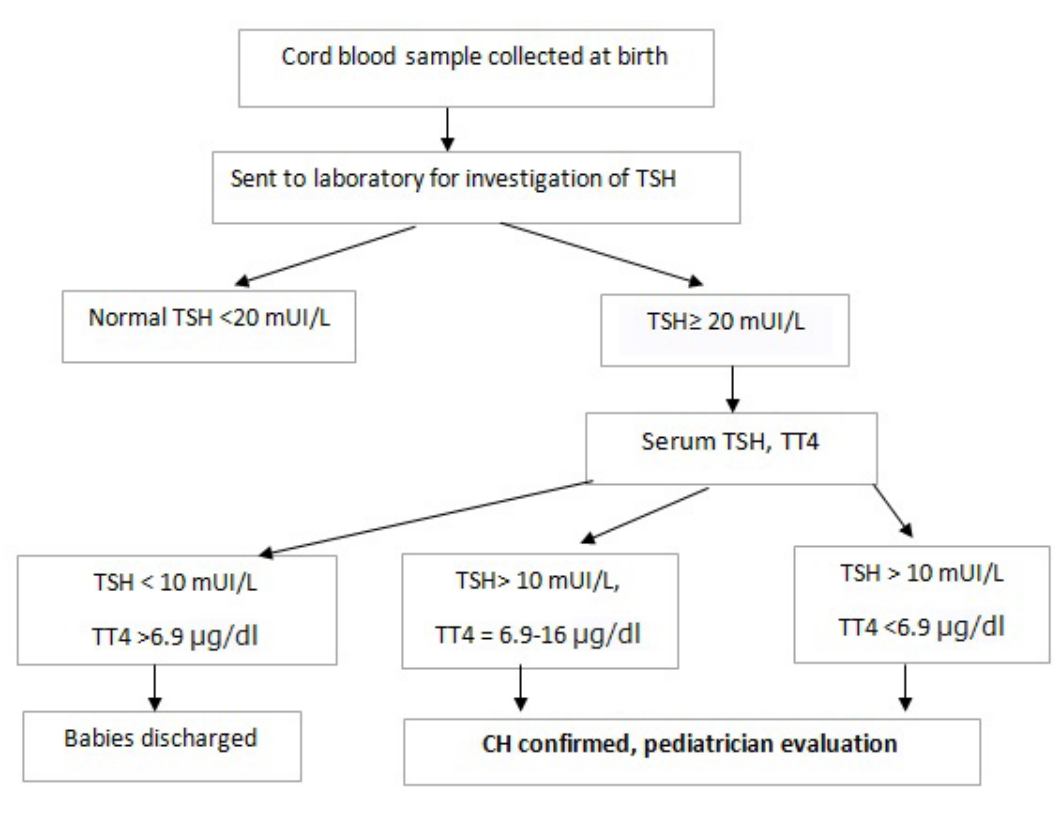
Figure 2. Flowchart for Screening of Congenital Hypothyroidism. The diagnostic of congenital hypothyroidism begins with either abnormal newborn screening test result, leading to serum thyroid function test (TSH and TT4) to confirm the diagnostic. Other diagnostic studies can be undertaken to determine the underlying